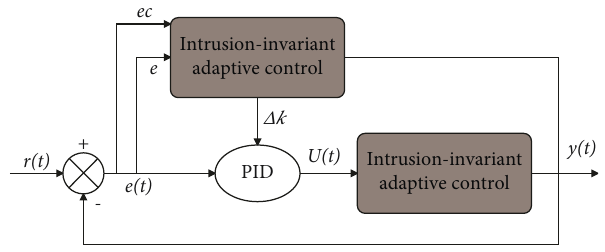
Figure 4: PID control structure of fuzzy neural network.